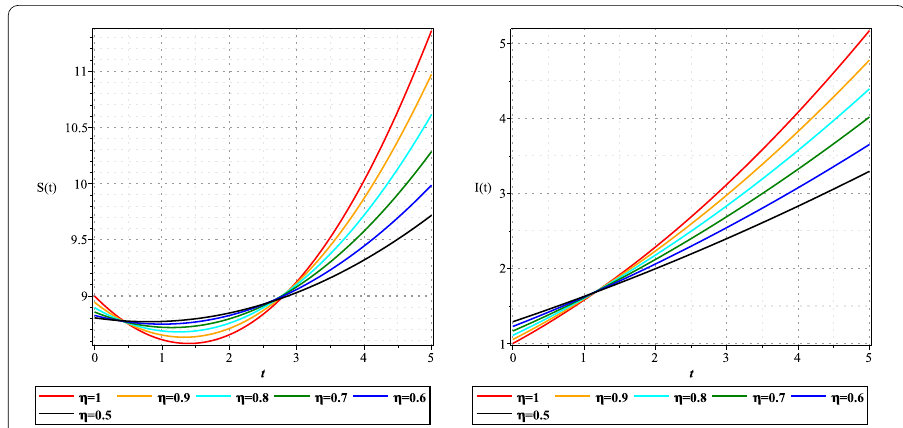
Figure 1 Dynamics of susceptible animals S and infected animals I for various values of η